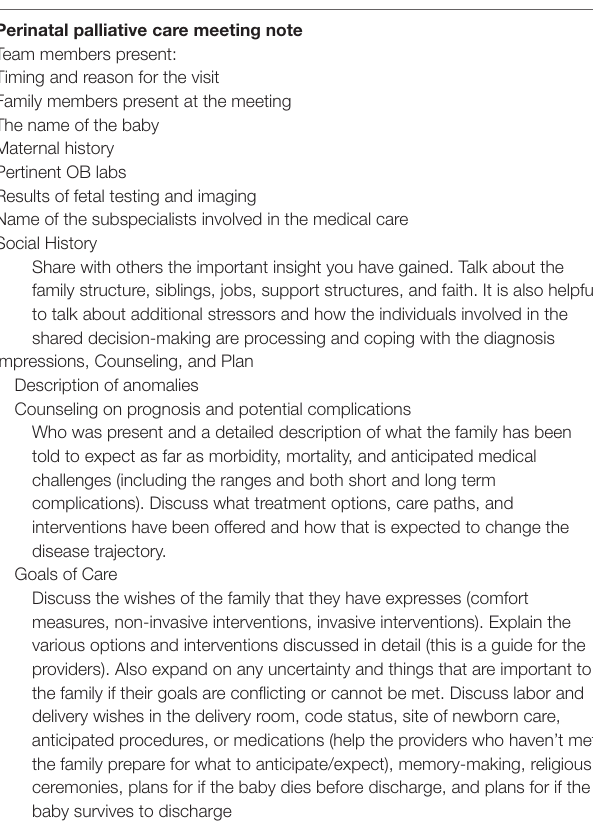
TABLE 4 | Important components of provider notes on birth